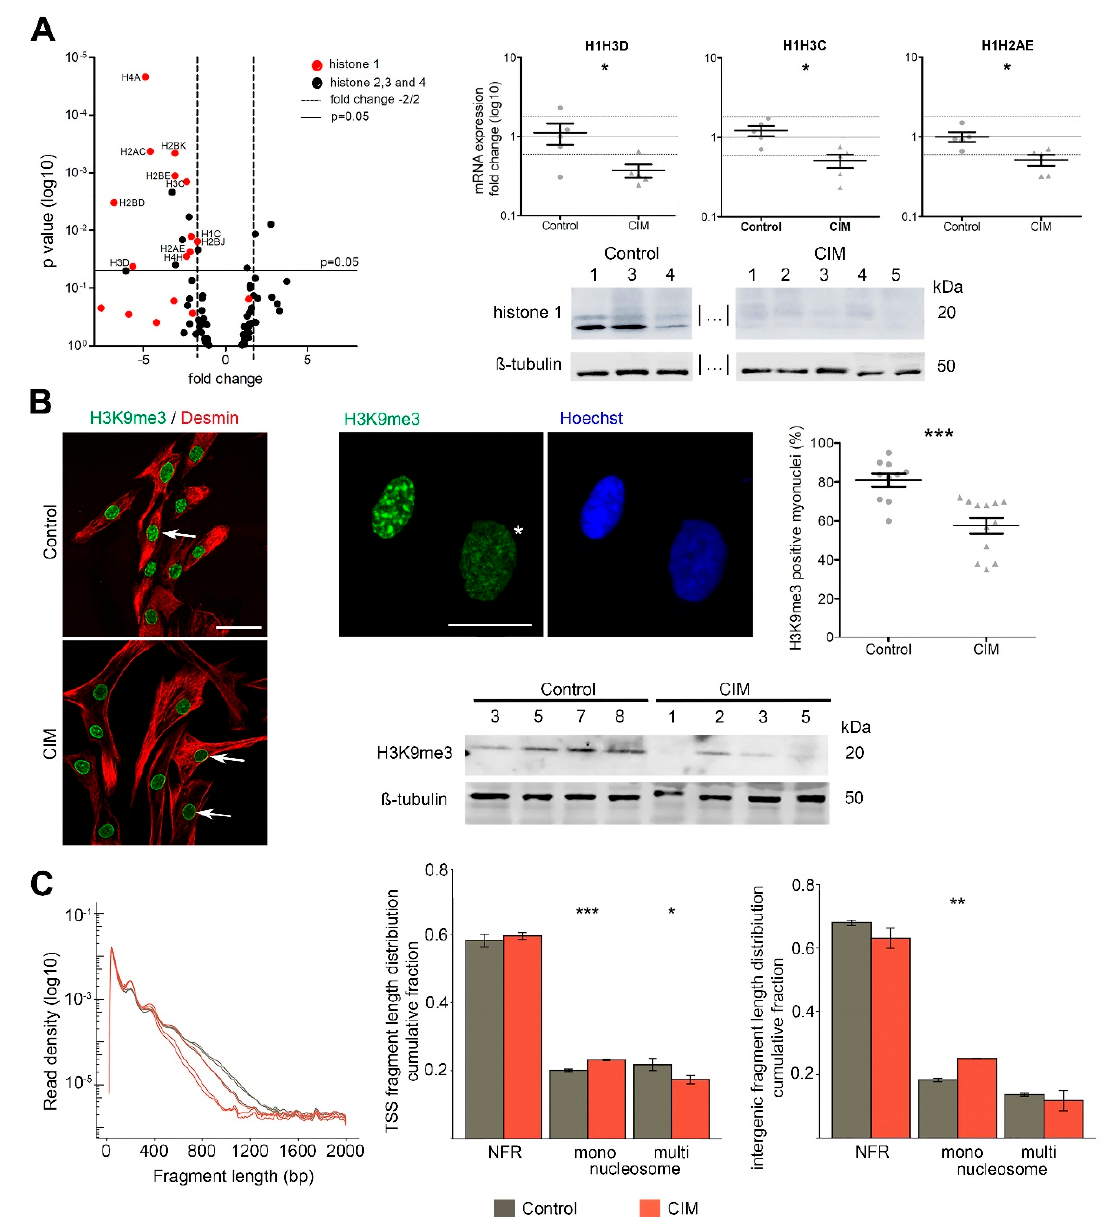
Figure 2. Opened chromatin state in CIM-MuSC. ( A ) RNA-Seq analysis of CIM and control MuSC. Confirmation by qPCR and on protein level by Western blot. Additional samples on the blot indicated by | . . . | are shown in Figure 5. ( B ) Immunofluorescent staining for desmin (red), H3K9me3 (green), Hoechst (blue); bar 50 µ m. Arrows: control: myonucleus positive for H3K9me3; CIM—absence of H3K9me3. Zoomed images: star: myonucleus from control MuSC with euchromatin, scale bar 10 µ m. On the right quantification of myonuclei positive for H3K9me3 (CIM, n = 12, mean 57%; controls, n = 10, mean 81%; p < 0.001). Western blot for H3K9me3. ( C ) ATAC-Seq analysis of CIM- and control MuSC. Global fragment length distribution plotted against read density to locate the expected open chromatin region (peak at < 100 bp) followed by nucleosome phasing pattern (peak every ~200 bp). Intergenic. Mono, single nucleosome spanning; multi, multiple nucleosome spanning; TSS—Transcription Start Site; NFR—Nucleosome Free Region. Data information: All values are expressed as mean ± SEM. In ( B ), at least 200 nuclei/cell population were counted for quantification. In ( A , B ), data were analyzed by Mann–Whitney U test; in ( C ), by t-test. * p < 0.05, ** p < 0.01, *** p < 0.001.